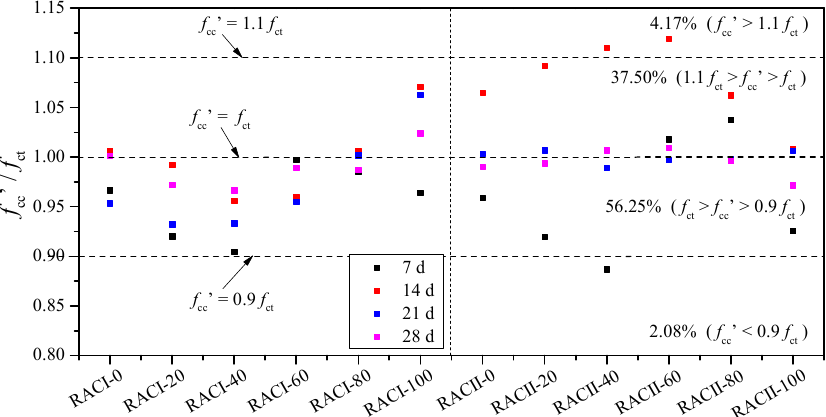
Figure 14. Unified fitting curve of coefficient γ 14d .